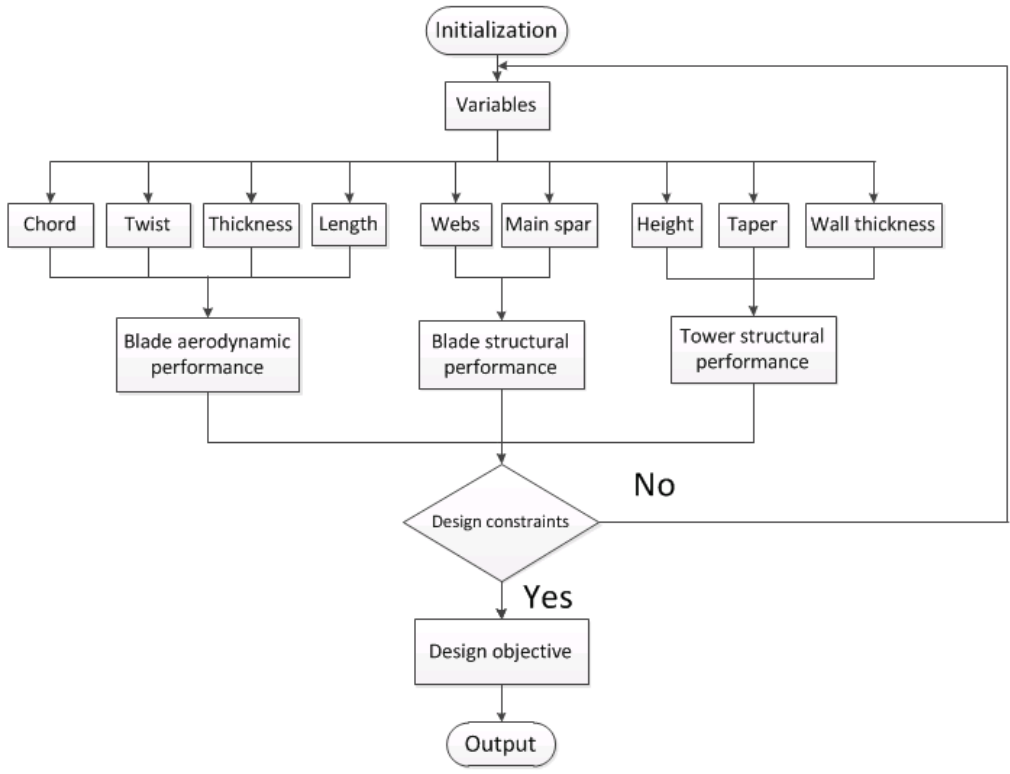
Figure 9. Flowchart of the optimization process.